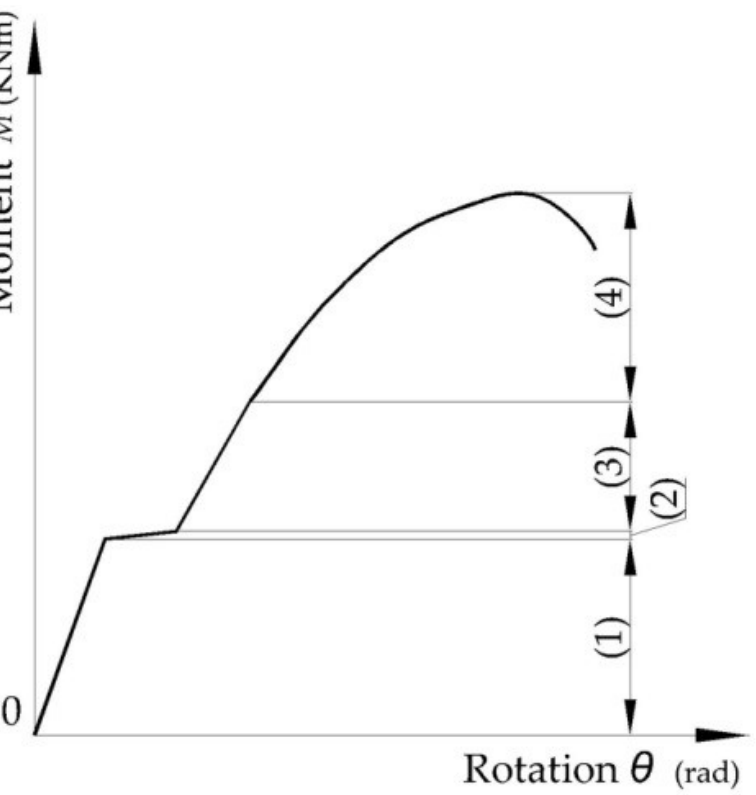
Figure 2. Typical behavior of bolted connections in cold formed steel structures: ( 1 ) linear behavior before slipping; ( 2 ) slipping effect caused by clearance between bold and hole; ( 3 ) linear behavior after cancelling of clearance; ( 4 ) nonlinear behavior.